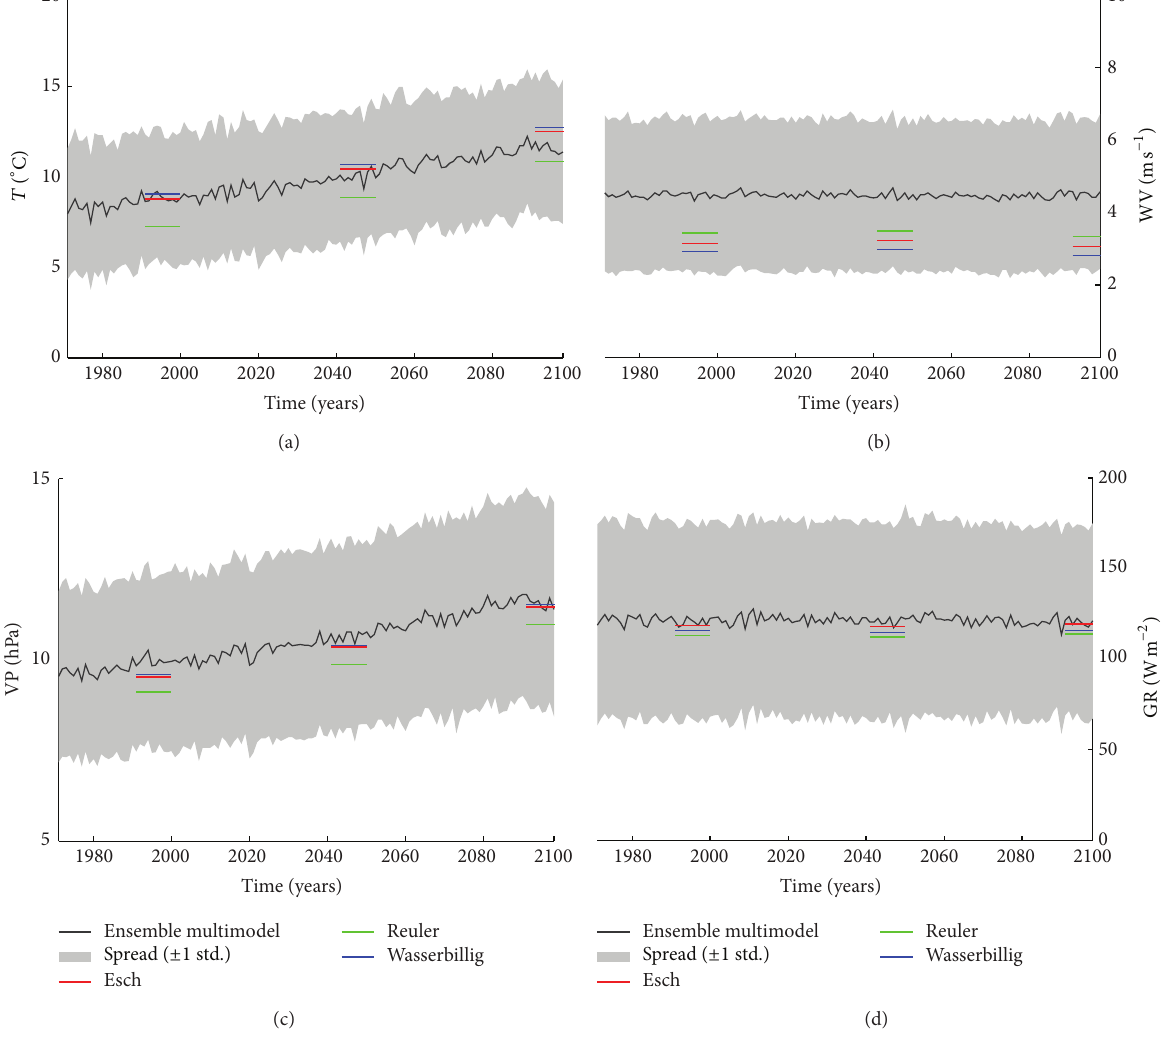
Figure 4: Projected meteorological parameters for the period from 1971 until 2098 using a multimodel ensemble of 12 transient simulations. Grey area shows the spread around the multi-model-mean (black line). Colored lines show the 10-year average results from high-resolution COSMO-CLM simulations for the three pseudo sites in